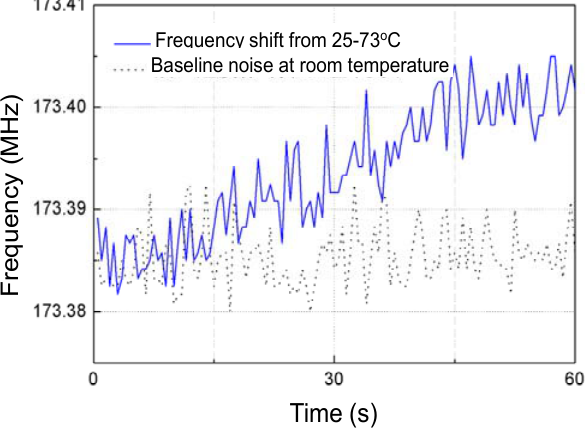
Figure 7. The measured baseline noise and time-dependent frequency response of the device